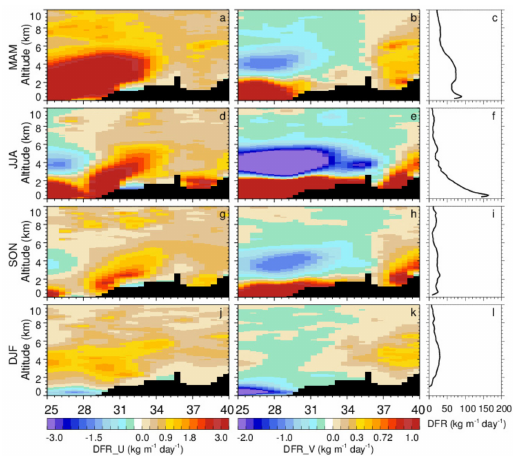
Figure 6. Vertical distribution of seasonal climatology of zonal ( left ) and meridional ( middle ) of DFR derived from CALIOP along the meridional cross-section of C1 (69 ◦ E) in ( a – c ) spring (MAM: March–April–May), ( d – f ) summer (JJA: June–July–August), ( g – i ) autumn (SON: September–October– November), and ( j – l ) winter (DJF: December–January–February). Here, the positive of zonal and meridional DFRs represent the dust transport eastward and northward, respectively. The profiles of integrated composited DFR ( right ) along the border at different seasons are also shown. Additionally, the positive of composited DFR means the Central Asian dust transport to the downstream areas.